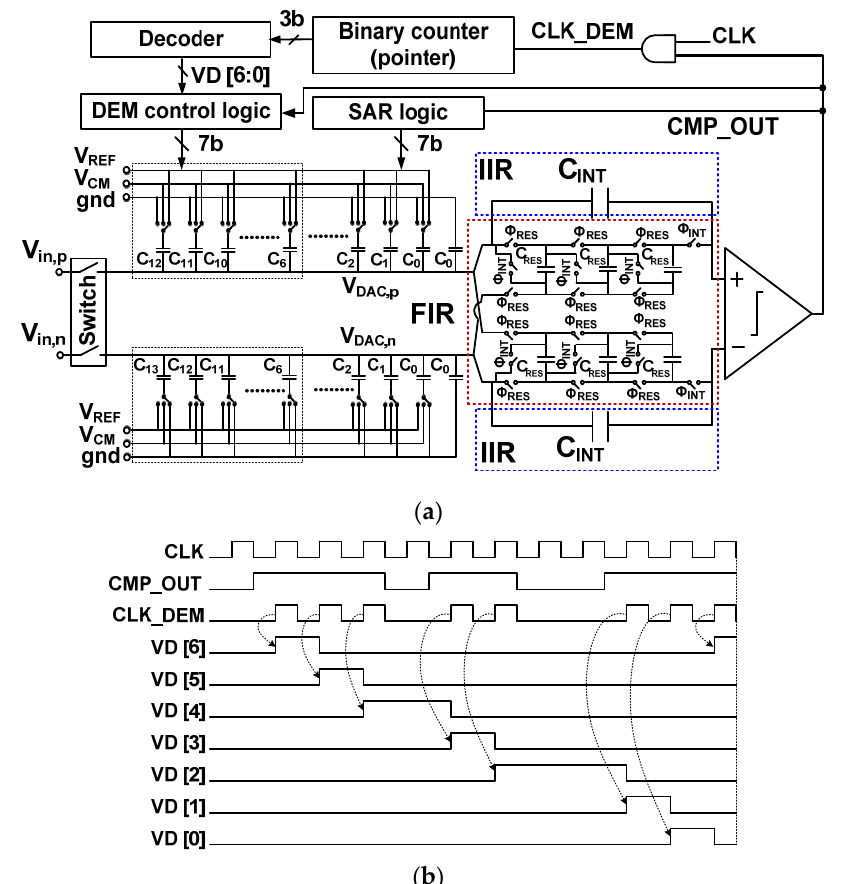
Figure 17. ( a ) Block diagram of the noise shaping ADC with the DEM. ( b ) Timing waveform of the DEM logic.